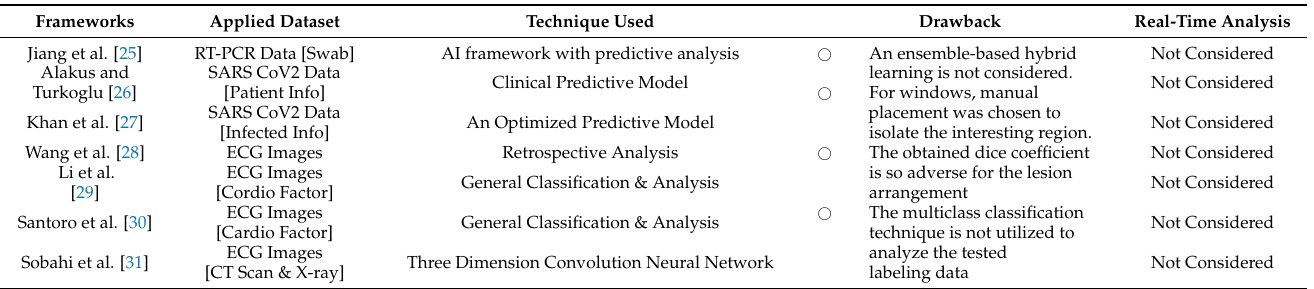
Table 1. Summarized the significant attributes of the existing frameworks for the early detection of